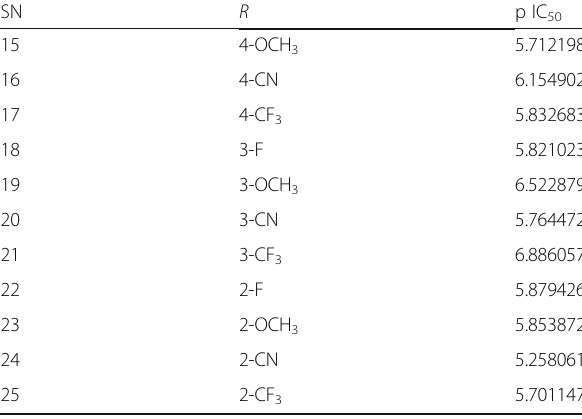
Table 4 Molecular structure of phthalazinone with substitution of phenyl moiety and their biological